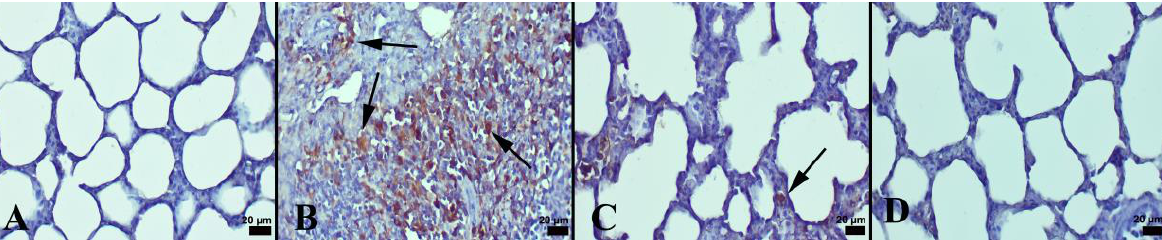
Figure 2. Cas-3 immunohistochemical findings among the groups: ( A ) negative expression in control group; ( B ) increased Cas-3 expression (arrows) in both alveolar epithelial cells and inflammatory cells (arrows) in LPS group; ( C ) decreased expression (arrow) in LPS + NBL group; and ( D ) no expression in NBL group, Streptavidin biotin method, scale bars = 20 µm.